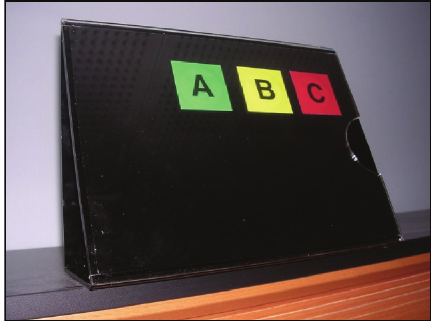
Figure 2: An NFC-enhanced plastic